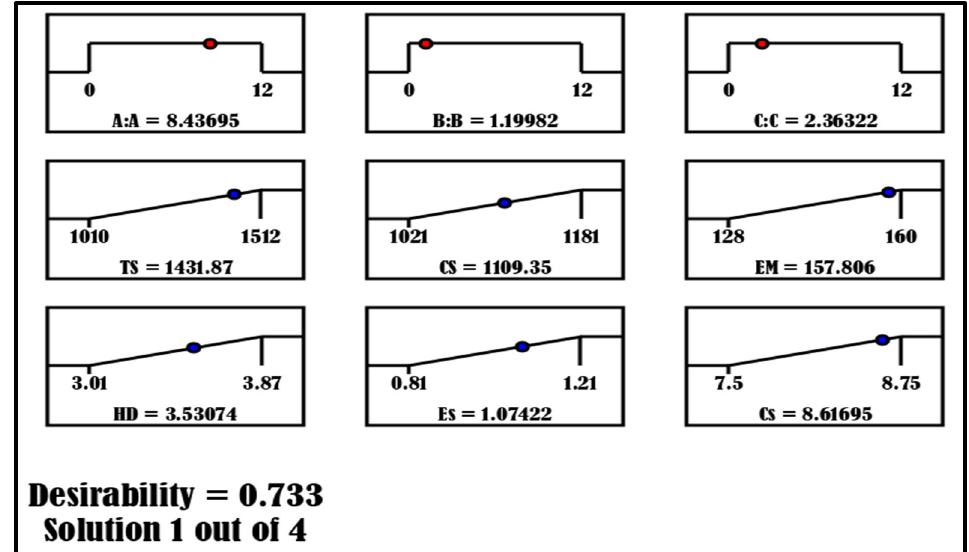
Figure 9. Optimization ramp.